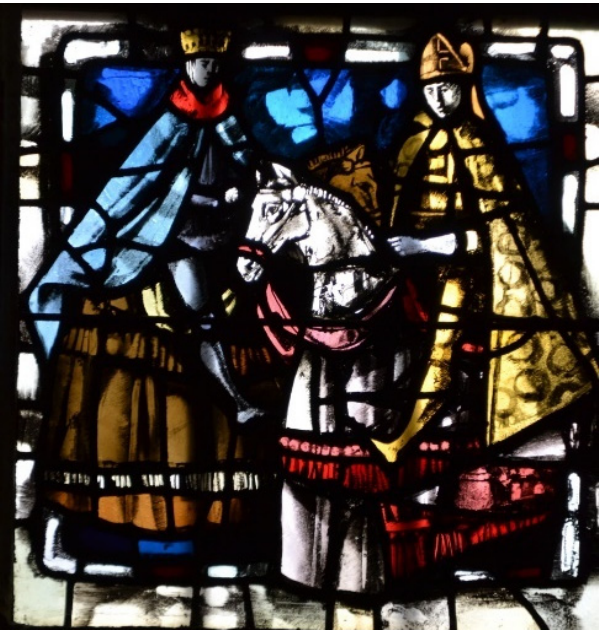
Figure 13. Saint-Lô, Church of Notre-Dame, Saint-Thomas chapel, Life of Saint Thomas window, 1968, detail, Meeting of Henry II and Thomas at Fréteval. © author.